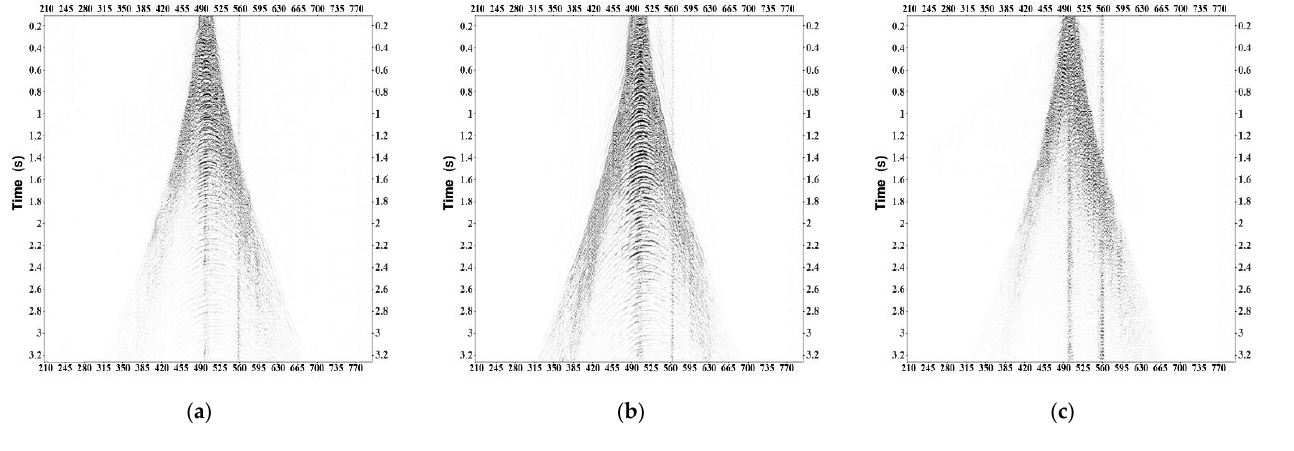
Figure 5. ( a ) The X-component wave field seismic record of the SH shear wave source. ( b ) The Y-component wave field seismic record of the SH shear wave source. ( c ) The Z-component wave field seismic record of the SH shear wave source.